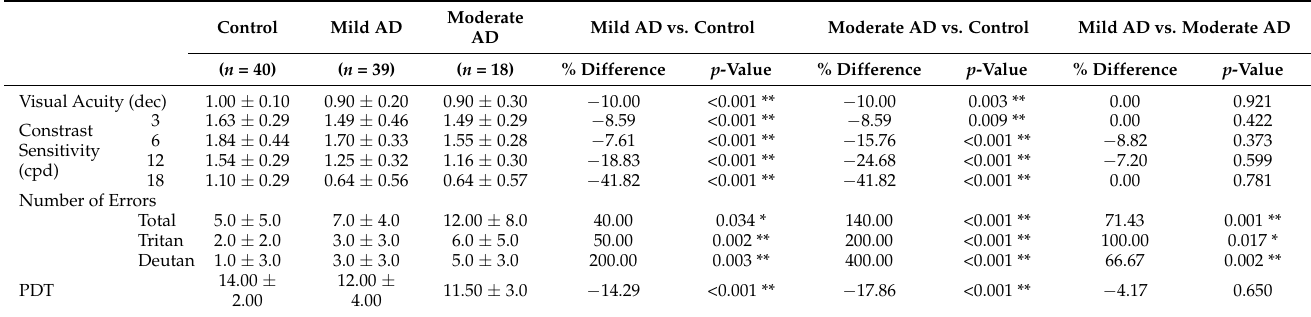
Table 3. Median data and p –value of the psychophysical tests [51].